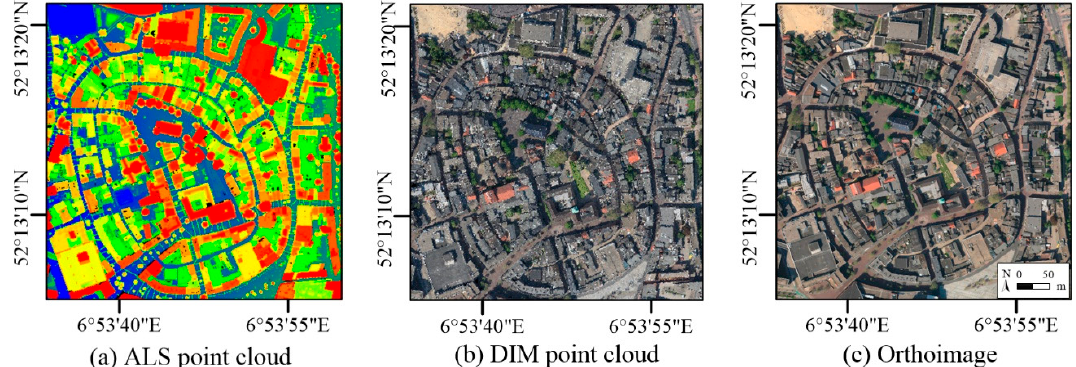
Figure 5. Visualization of the Rotterdam study area. ALS point cloud is colored according to height. DIM point cloud is colored with true color.